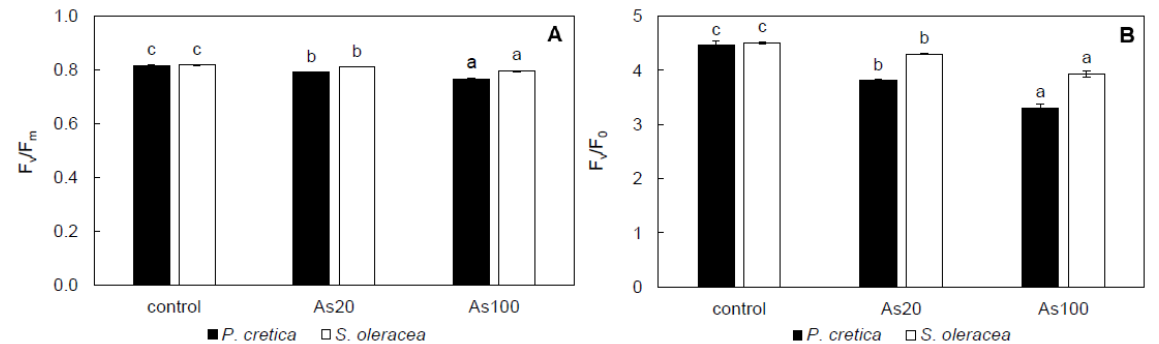
Figure 3. Effect of As treatments on maximal quantum yield ( A ) and maximum primary yield of PSII ( B ) in Pteris cretica and Spinacia oleracea . Values represent the mean ± SE of three biological replicates per sample. Data with the same letter are not significantly different. Different letters indicate significant differences ( p ≤ 0.05) among treatments according to the Kruskal-Wallis test. Abbreviations: control—0 mg As/kg soil; As20—20 mg As/kg soil; As100—100 mg As/kg